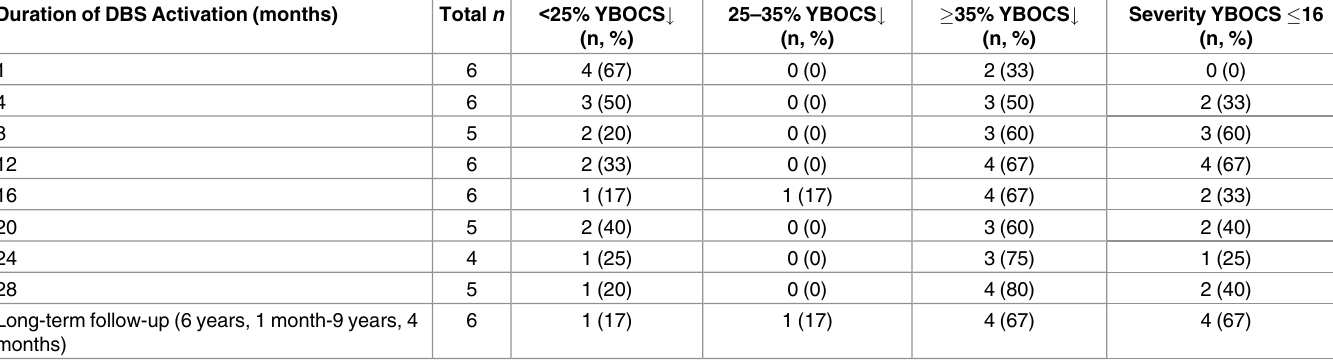
Table 1. Categorical Responses and Long-Term Follow-Up During DBS for OCD ( n = 6). Duration of DBS Activation